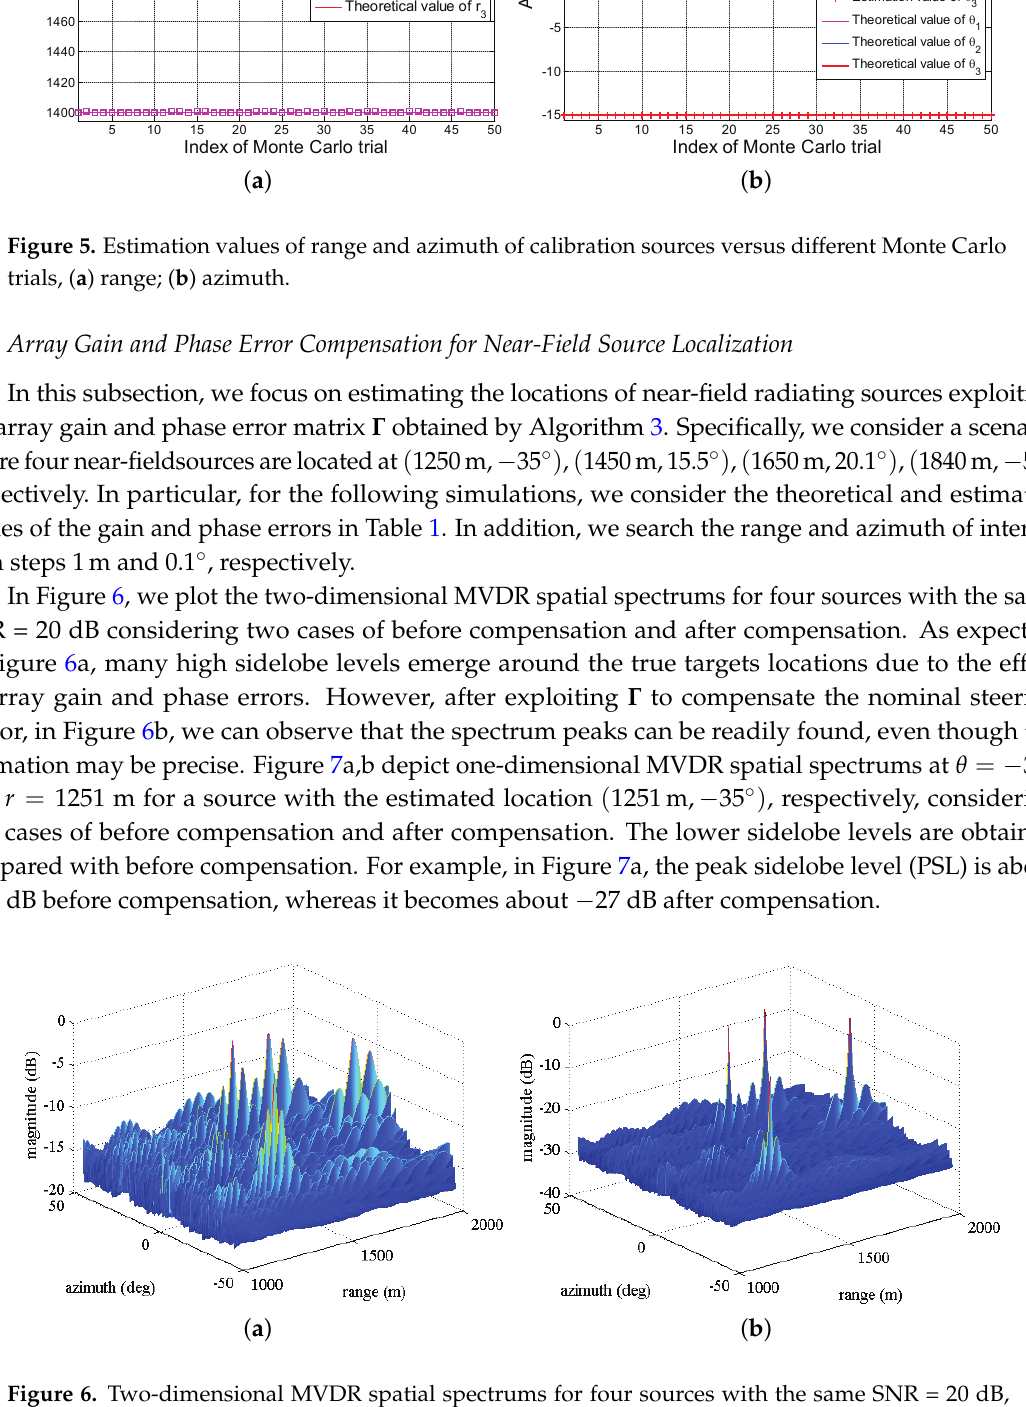
Figure 6. Two-dimensional MVDR spatial spectrums for four sources with the same SNR = 20 dB, ( a ) before calibration; ( b ) after